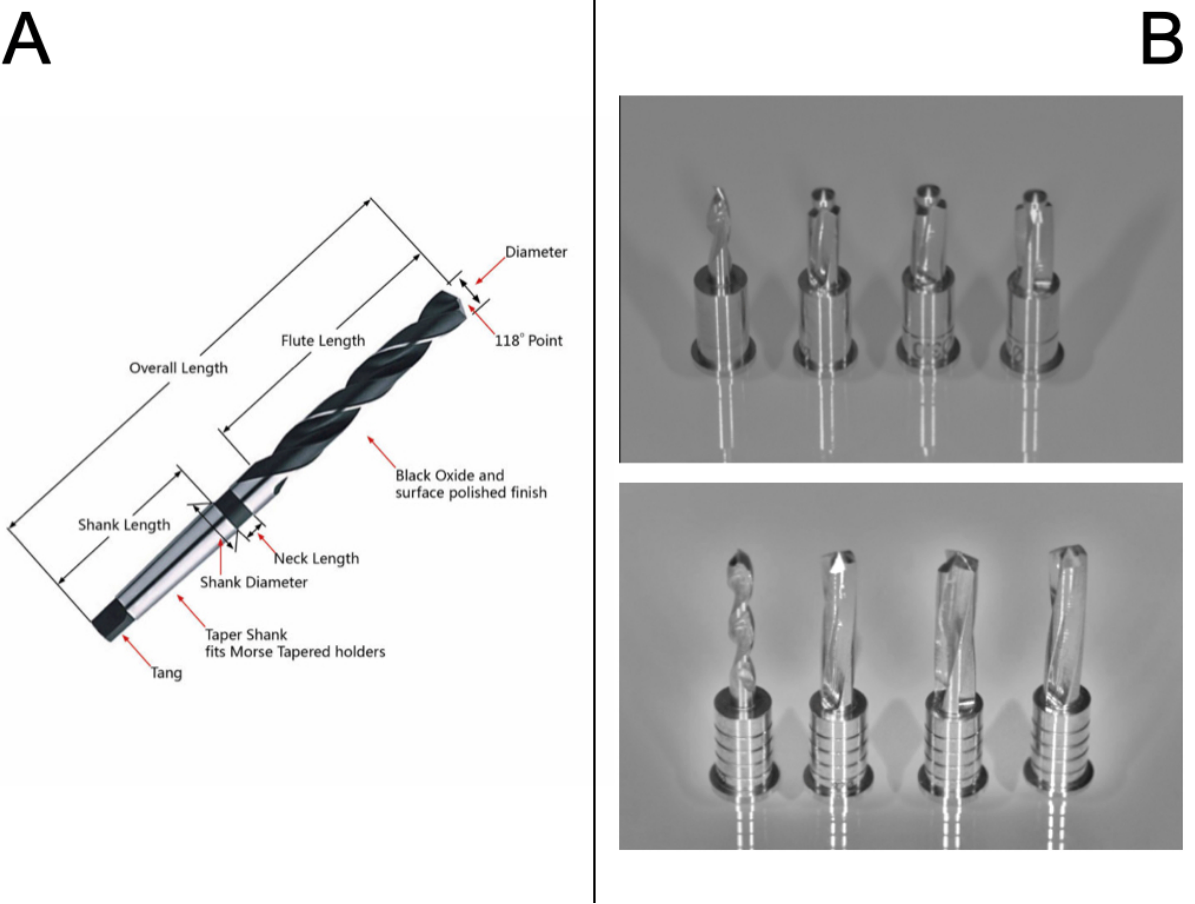
Figure 1. ( A ) Structure of conventional drills for guided implant surgery. ( B ) Innovative patented drills, with a reduced length.